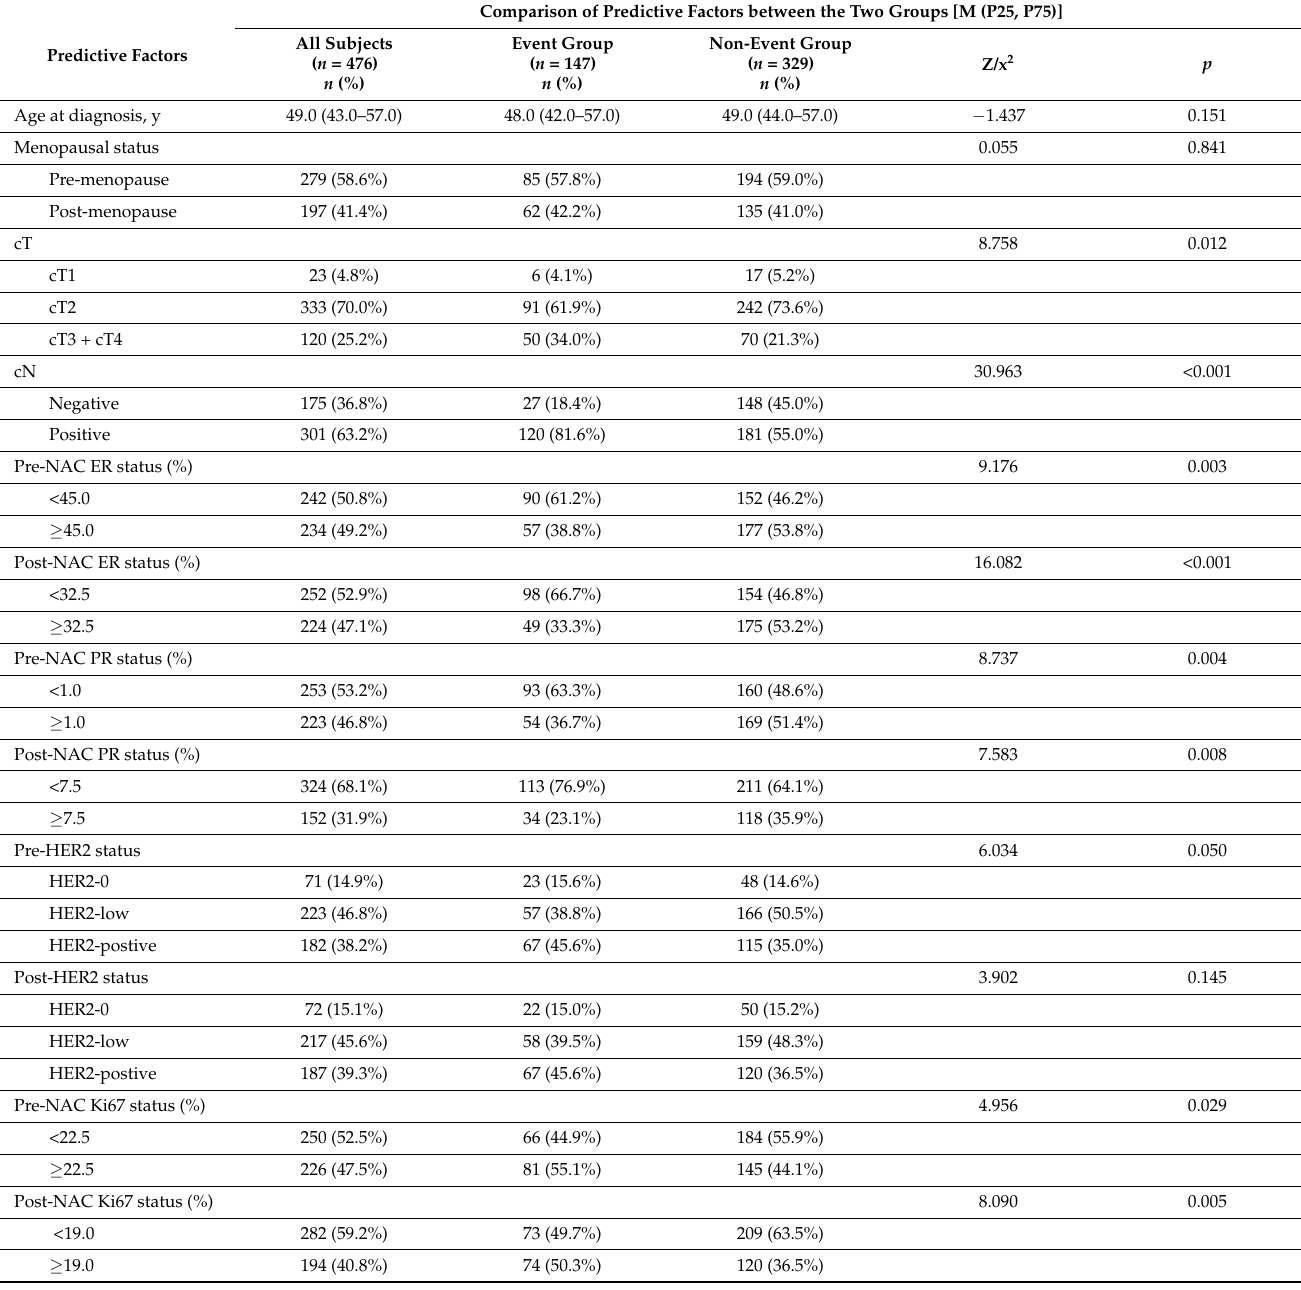
Table 1. Baseline clinicopathological characteristics and univariate